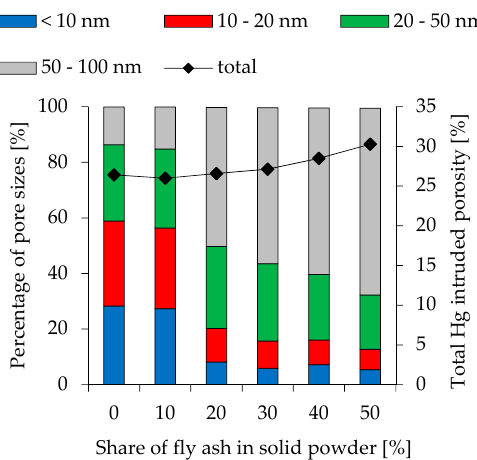
Figure 10. Pore size distribution of geopolymers cured for 28 days (l/s 0.60).